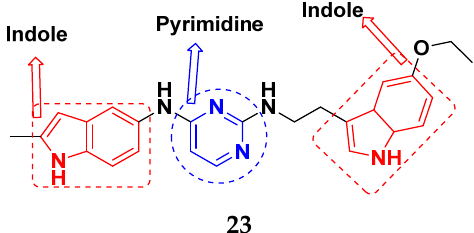
Figure 26. A pyrimidine ‐ indazole based hybrid 22 . Hogberg et al. (2012) developed and patented indole based pyrimidine hybrids and evaluated their anticancer activity as tubulin inhibitors. Among the synthesized com- pounds, compound 23 (Figure 27) showed potent activity on CCRFCEM (T lymphoblastoid cells) with an EC 50 value of 0.015 µ M [74].